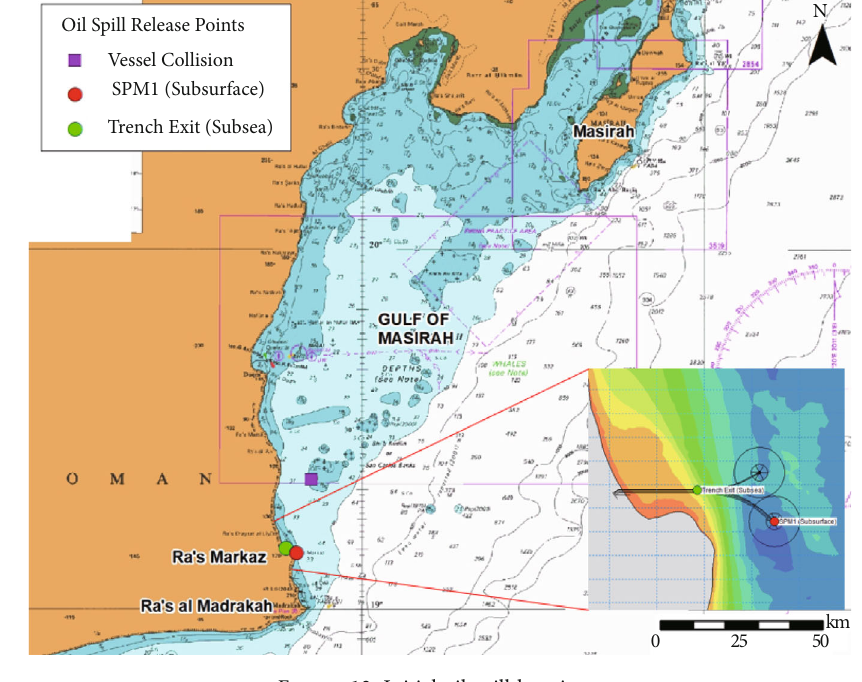
Figure 12: Initial oil spill locations.